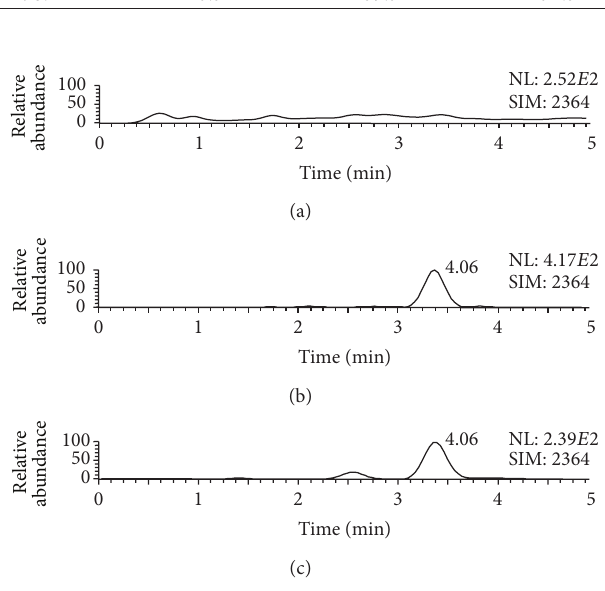
Figure 2: Representative SIM chromatograms for 𝛼 -La of (a) water, (b) water spiked with 𝛼 -La at the LLOQ, and (c) a lactose sample.